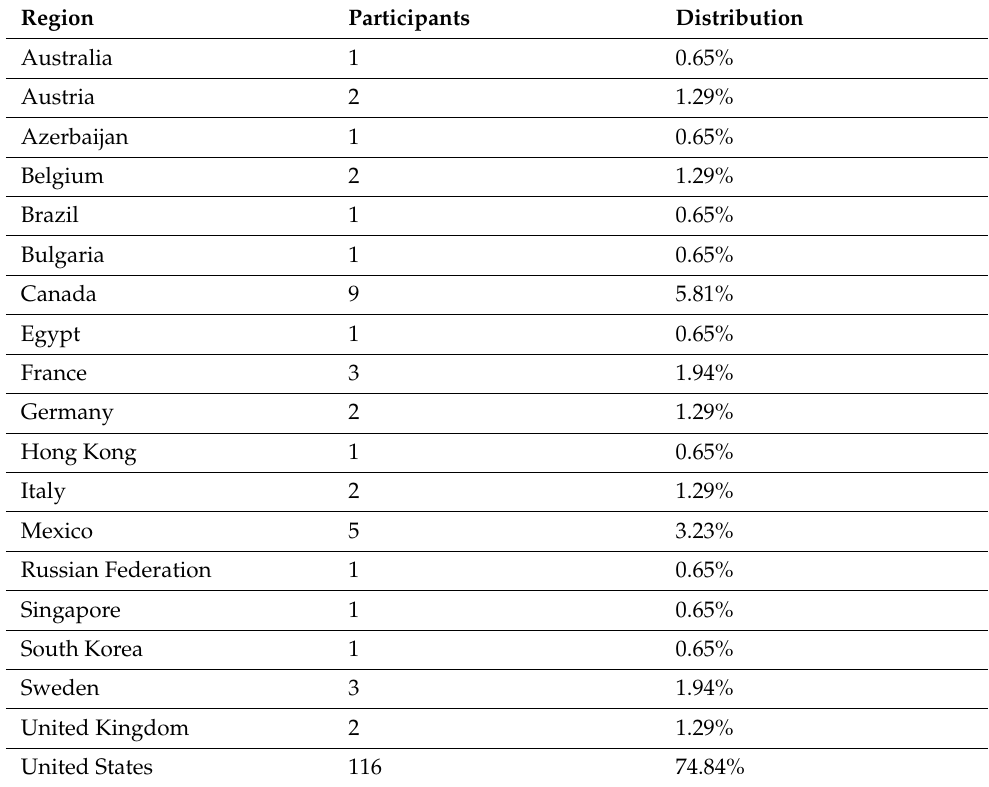
Table 2. Hep-DART 2021 delegate demographics by